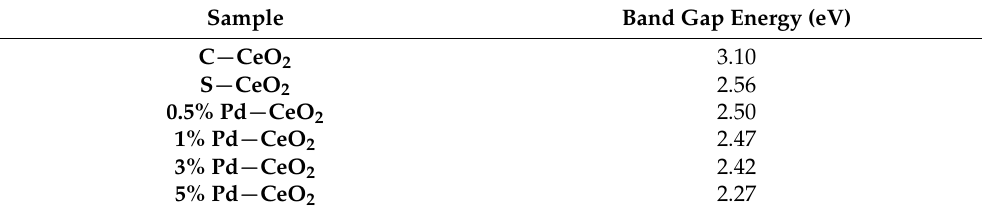
Table 3. Band gap energy of C − CeO 2 , S − CeO 2, and Pd − CeO 2